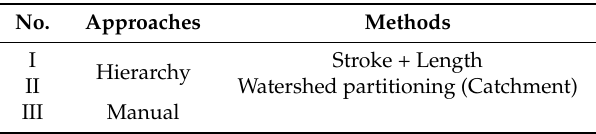
Table 2. Testing on three generalization methods.